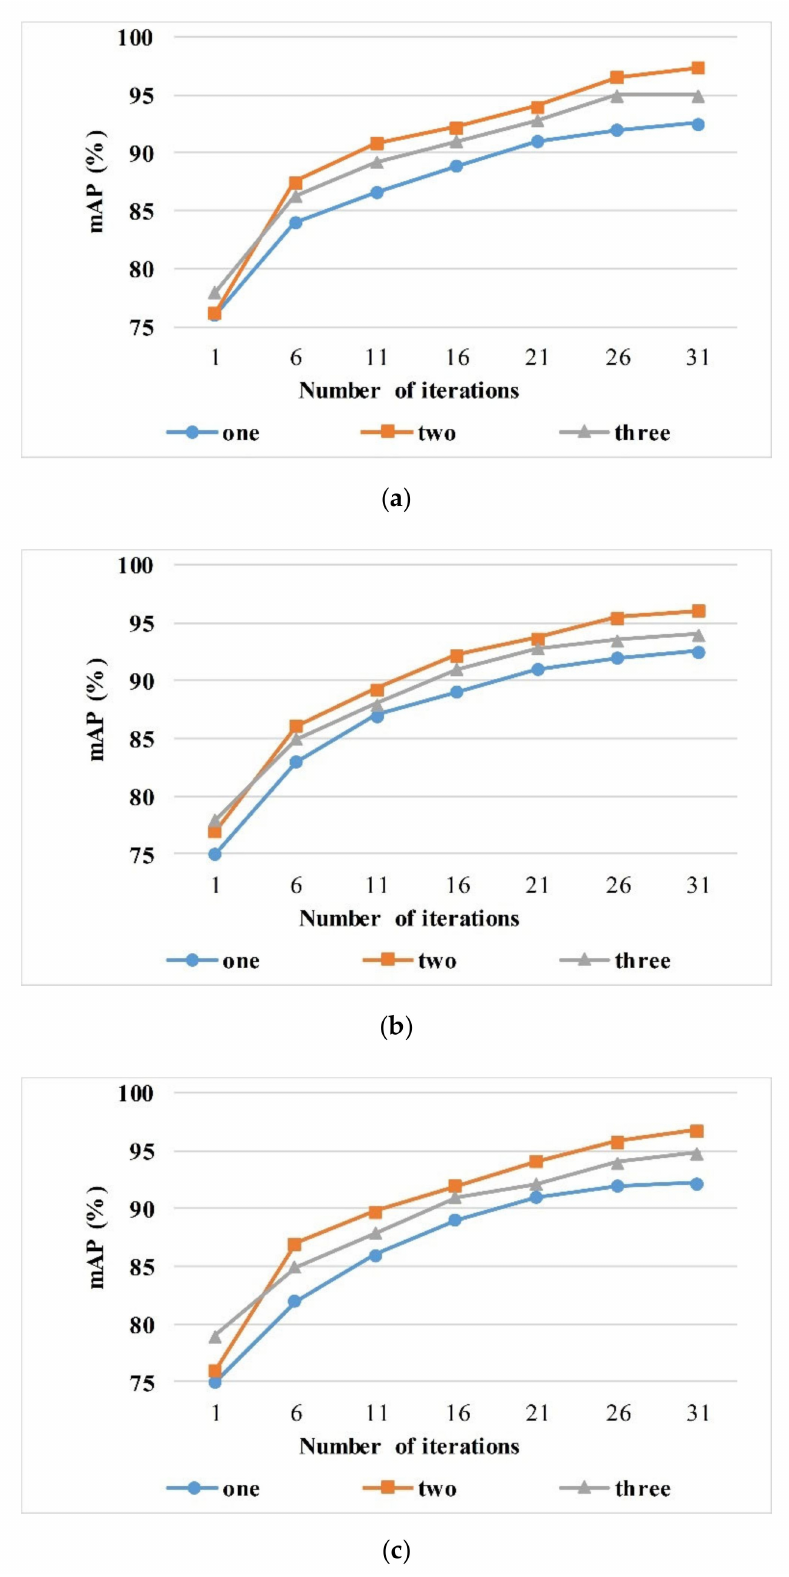
Figure 2. The influence of numbers of descriptors on mAP. The evaluation is performed with our architecture on ( a ) UCMD, ( b ) SIRI-WHU, and ( c ) AID. The curve represents the evolution of mAP in the training